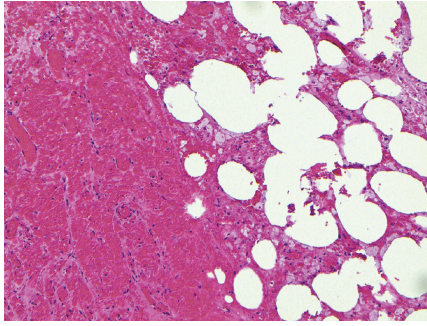
Figure 4: Gross image showing hemorrhagic infarction and necrosis of the omentum.